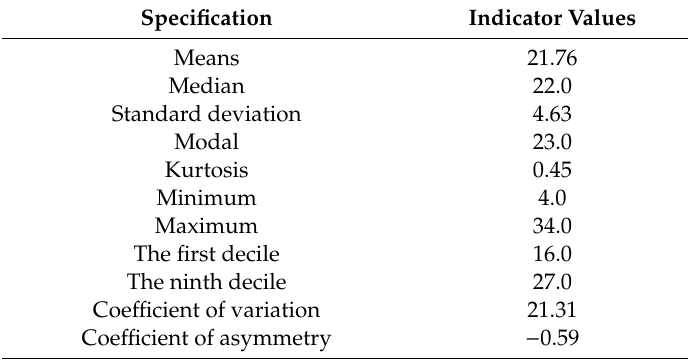
Table 3. The values of descriptive statistics aggregate index for single-person households.